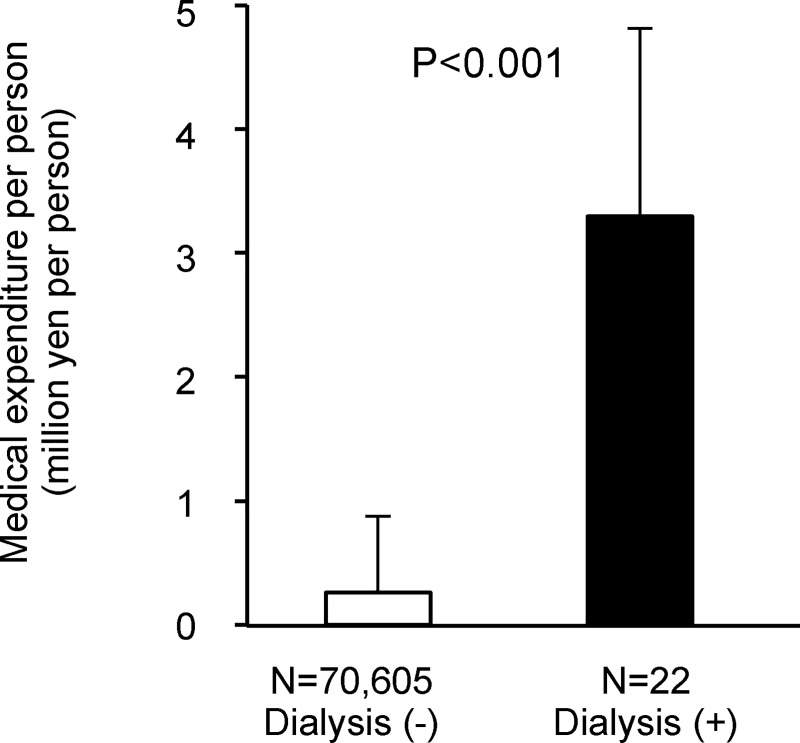
Mean medical costs in the 12 months among the subpopulations starting and not starting chronic dialysis.Patients on chronic dialysis in the baseline year and/or the next year were excluded from the analysis. Therefore, initiation of dialysis occurred in 2014. Error bars show the standard deviations. Abbreviations: eGFR, estimated glomerular filtration rate; ΔGFR, annual changes in eGFR.